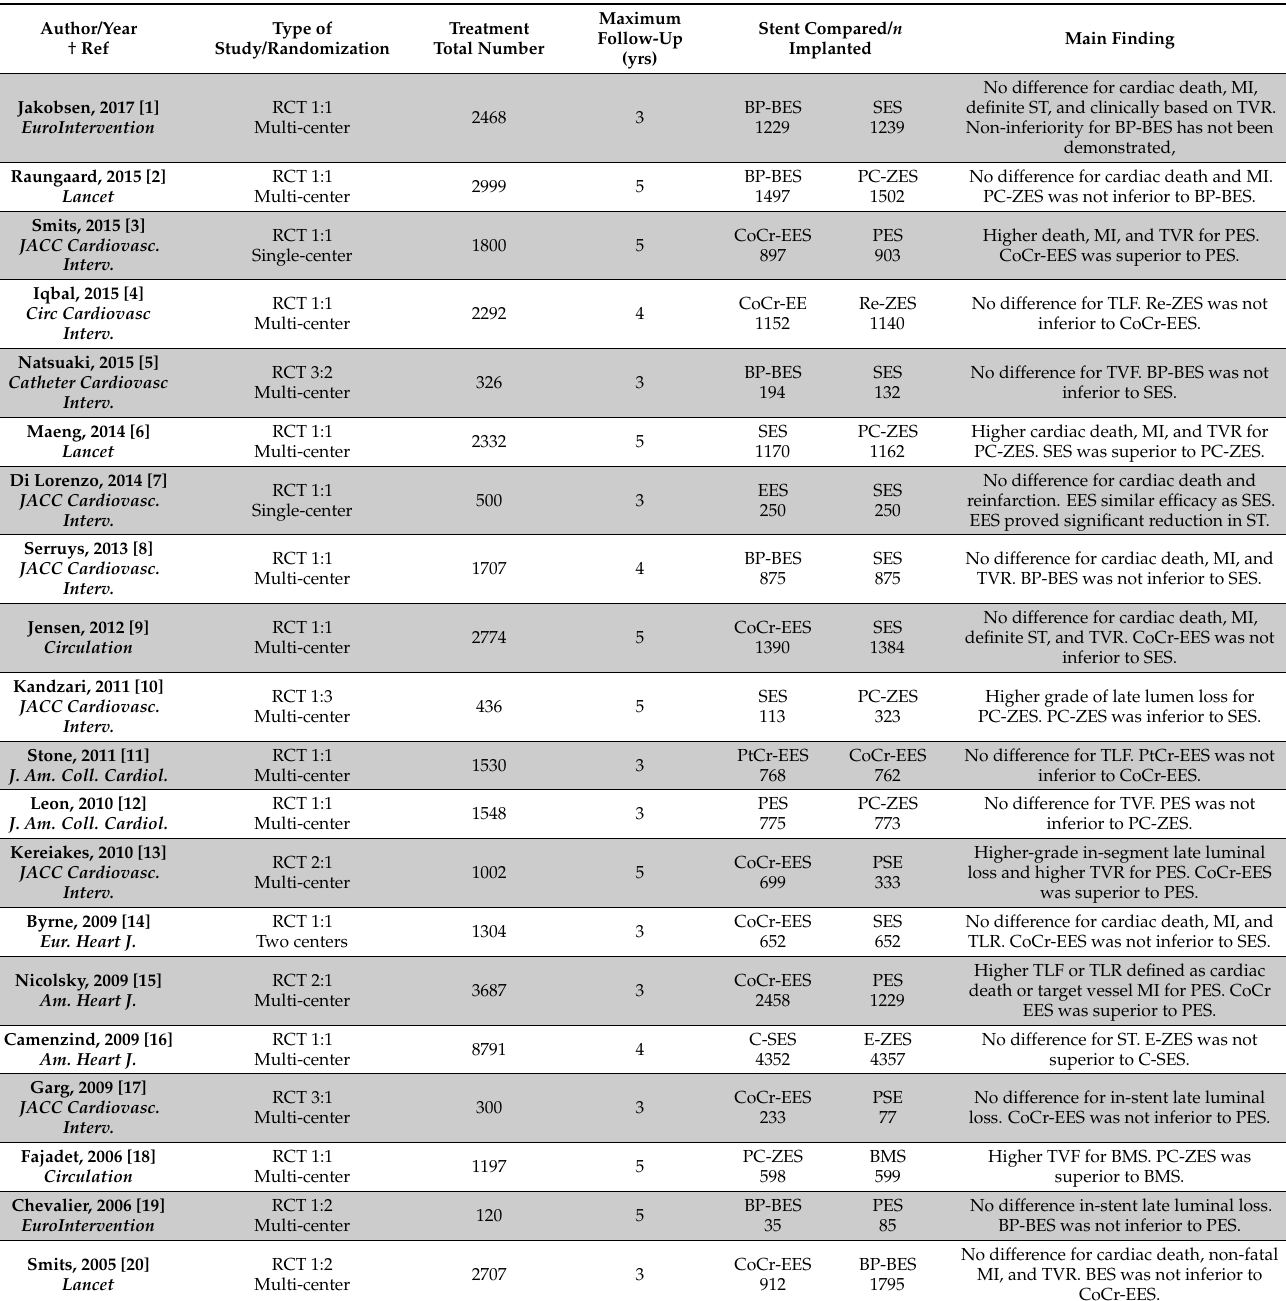
Table 2. Summary of contemporary series comparing second-generation DESs. Abbreviations. BP-BES =